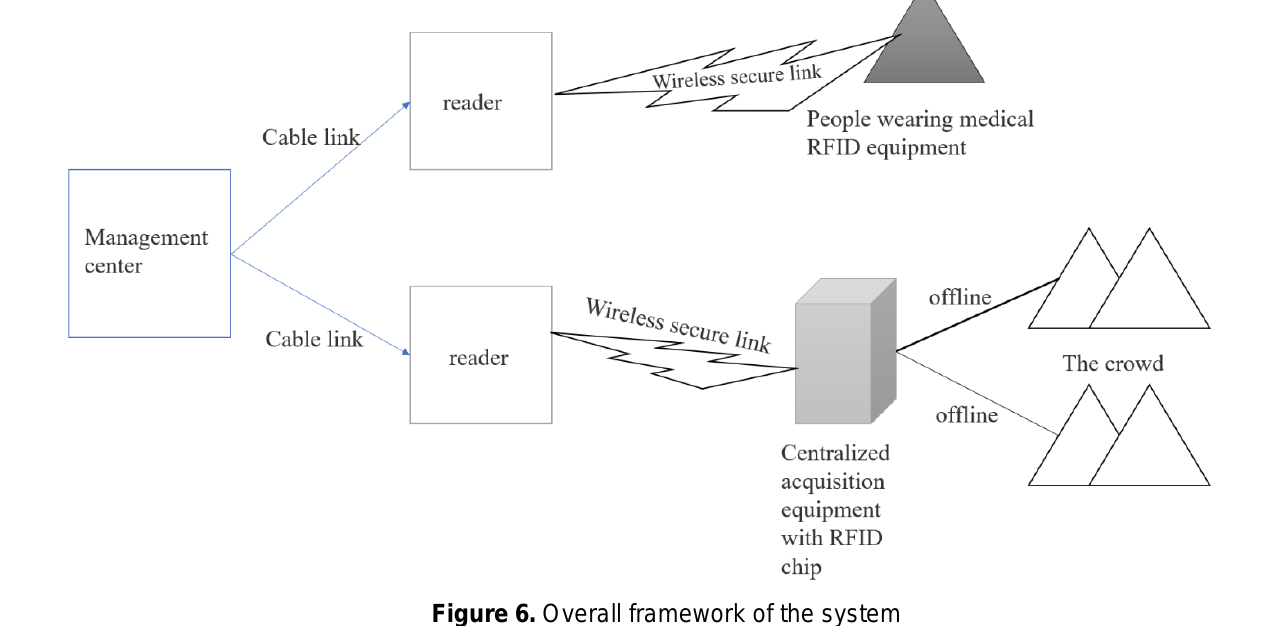
Figure 6. Overall framework of the